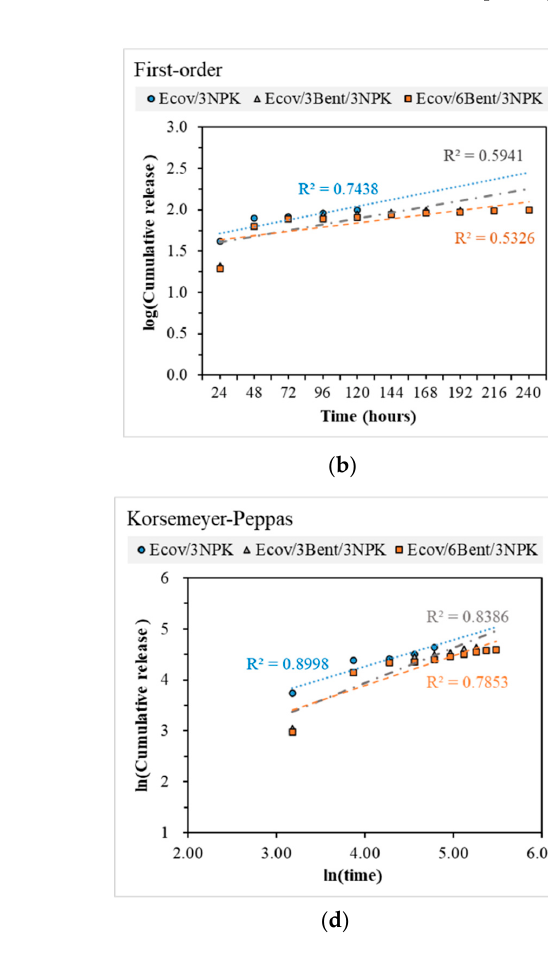
Figure 6. Data fitting to ( a ) zero-order; ( b ) first-order; ( c ) Higuchi; ( d ) Korsmeyer-Peppas kinetic models for NPK release by the different composites investigated.